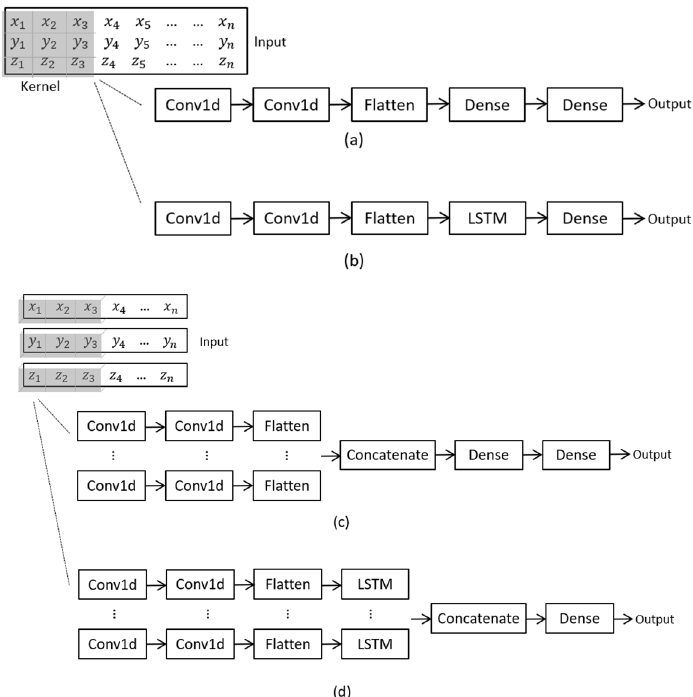
Figure 1. Structures of the neural networks: ( a ) 1D CNN, ( b ) CNN-LSTM, ( c ) multichannel CNN, ( d ) multichannel CNN-LSTM. x, y, z represent the triaxial accelerometer data. Abbreviations: CNN, convolutional neural network; LSTM, long short-term memory.